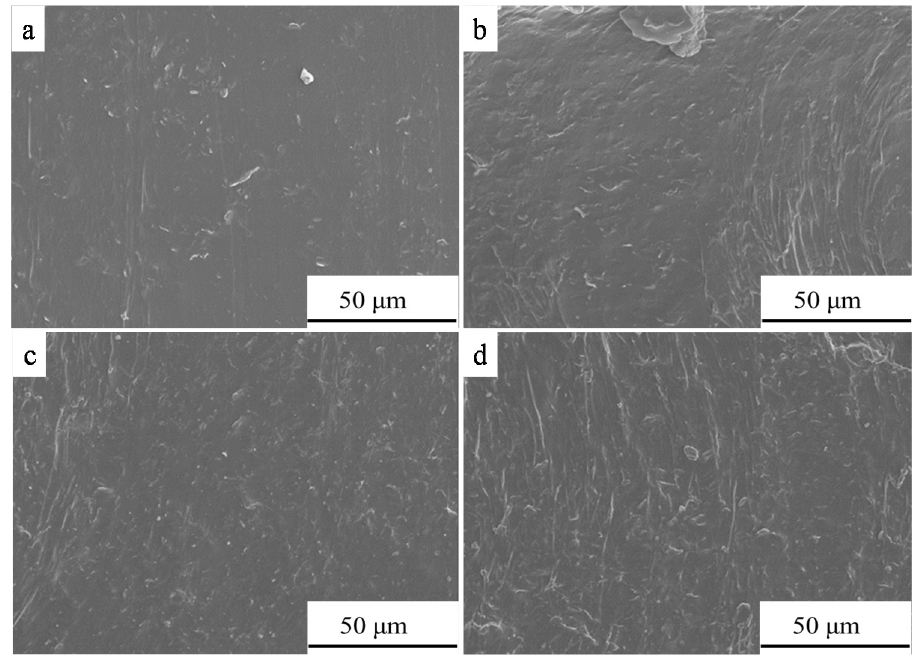
Figure 4. SEM images of the cross-section morphology of the GO-TPU films prepared with the loading of GO of 1 wt % ( a ), 2 wt % ( b ), 3 wt % ( c ), and 5 wt % ( d ), respectively.